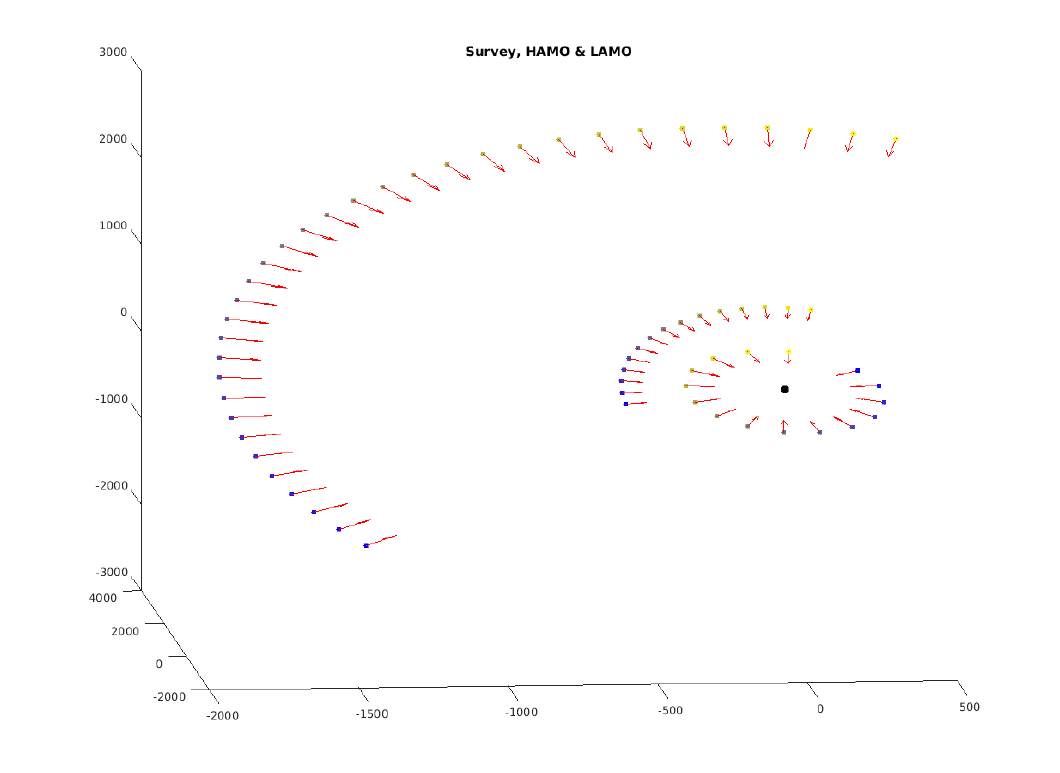
Figure 16. DAWN S/C positions relative to 4 Vesta during the survey, HAMO and LAMO phase. Orientations of the camera (FC 2) are shown as red arrows, and the color of each dot represents time during each mission phase from yellow (early) to blue (later)